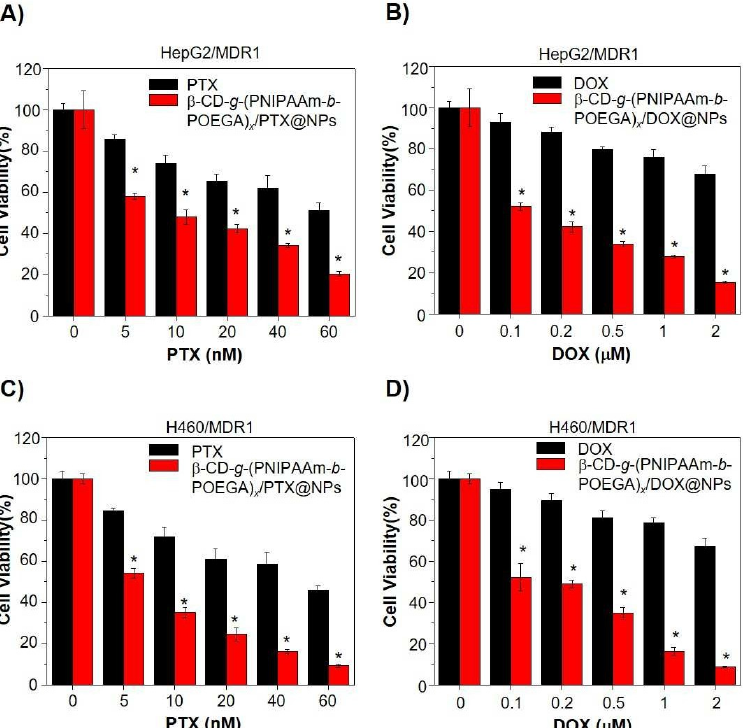
Figure 6. Cell viability assay to study β -CD-g-(PNIPAAm-b-POEGA)x/drug complex nanoparticles for reversing MDR1-related drug resistance. ( A , C ) Cell viability of ( A ) HepG2/MDR1 and ( C ) H460/MDR1 after 24 h treatment with indicated doses of PTX complex nanoparticles or equivalent PTX only. ( B , D ) Treatment with DOX complex nanoparticles or equivalent DOX only in ( B ) HepG2/MDR1 and ( D ) H460/MDR1 cell lines for 24 h. Data represented in the form of mean ± standard deviation. * p < 0.05, with comparison to growth inhibition of PTX or DOX treatment only, n = 6 (Reprinted with permission from Ref. [67]. 2018, Hongwei Cheng).